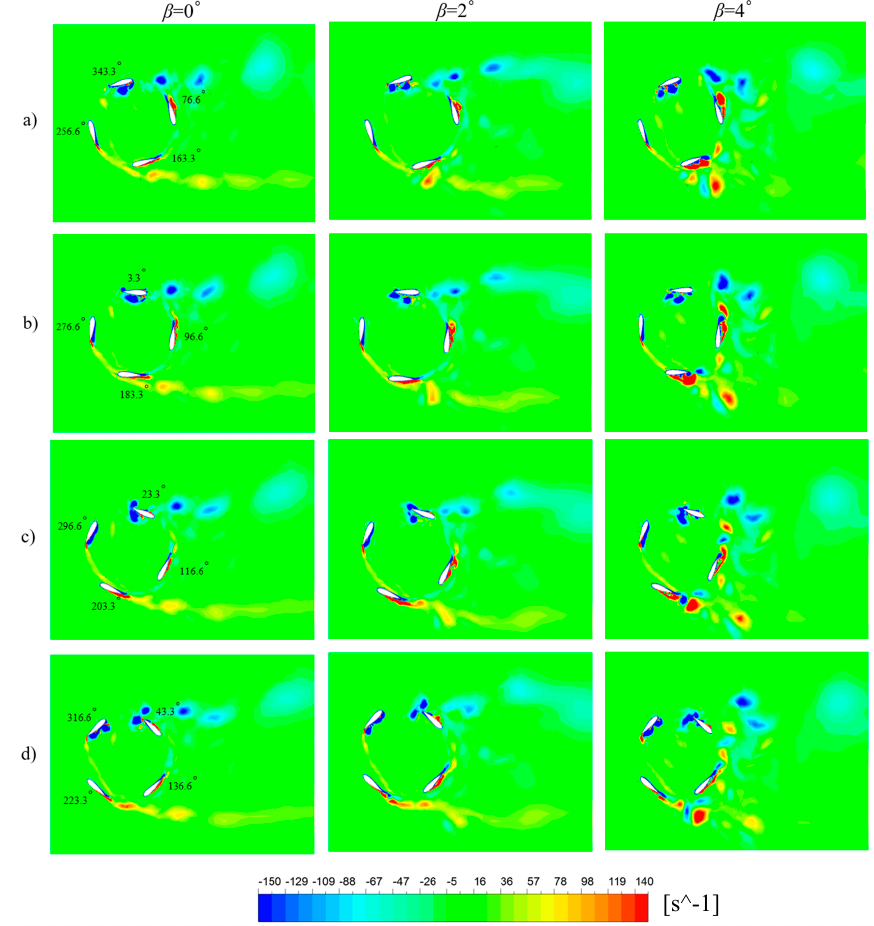
Figure 10. Instantaneous Z-vorticity (s − 1 ) field at R = 0.46 m for β = 0° (left), β = 2° (center), β = 4° (right) at TSR = 1.0.